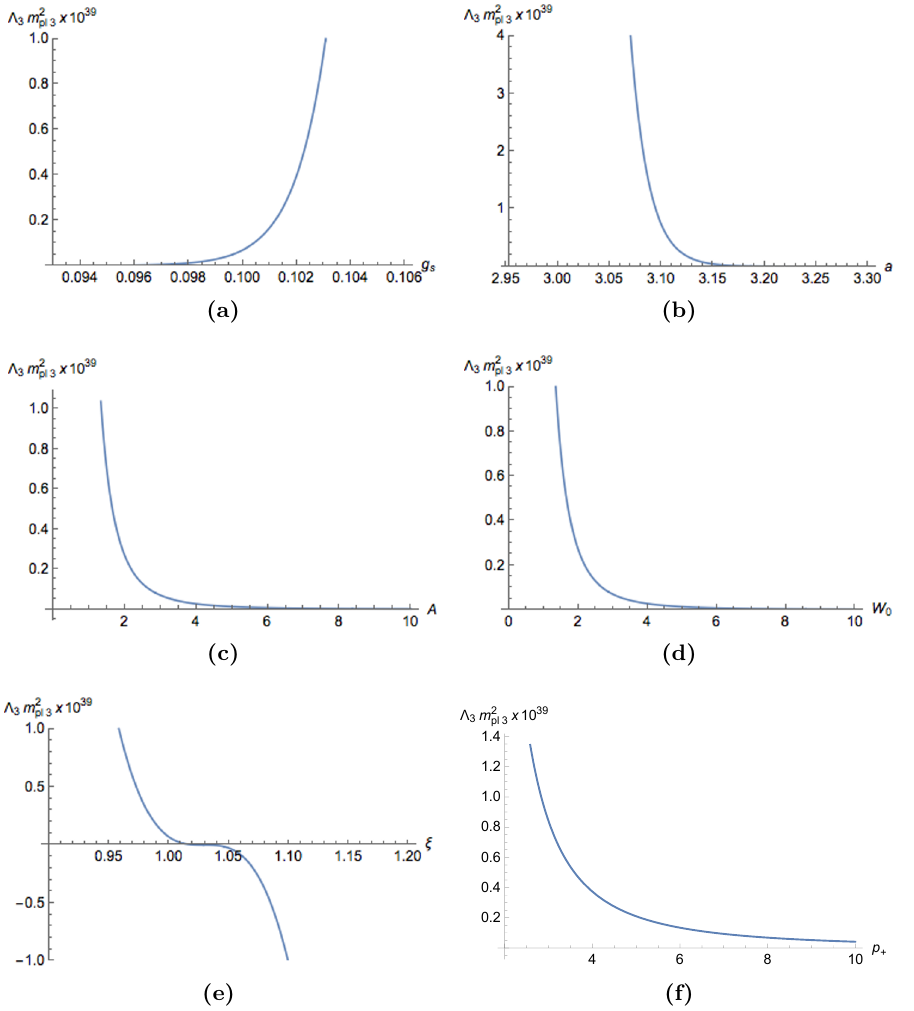
Figure 5. A plot of how the cosmological constant changes while varying the LVS